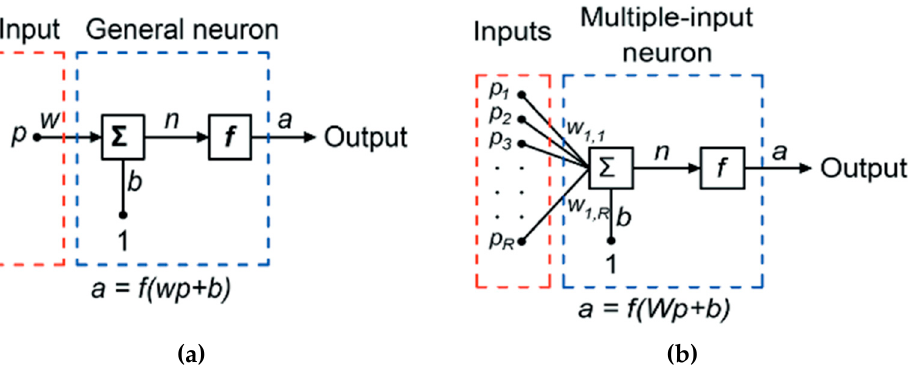
Figure 14. ( a ) Single-input neuron, ( b ) multiple-input neuron. Initially, the term p is a scaler unit, multiplying with scalar weight W , and forms a product W P . Next, the weighted input W P is added with scalar bias b to develop a net input